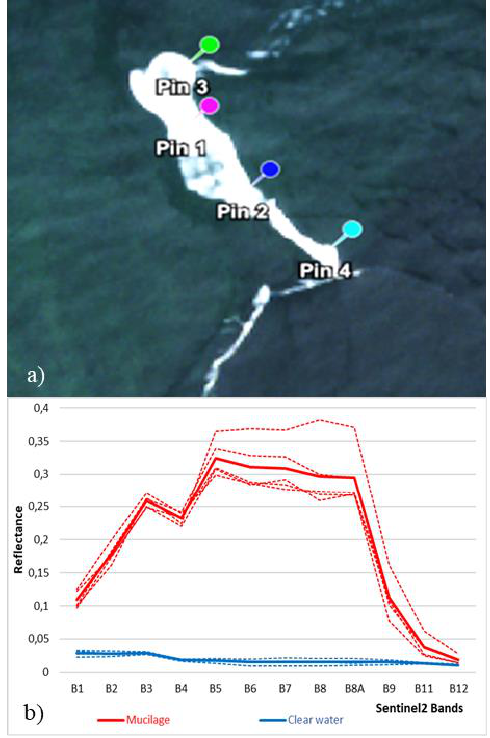
Figure 2. Example (a) of mucilage samples collected from the Sentinel-2 image. (b) Reflectance spectra of mucilage and clear water